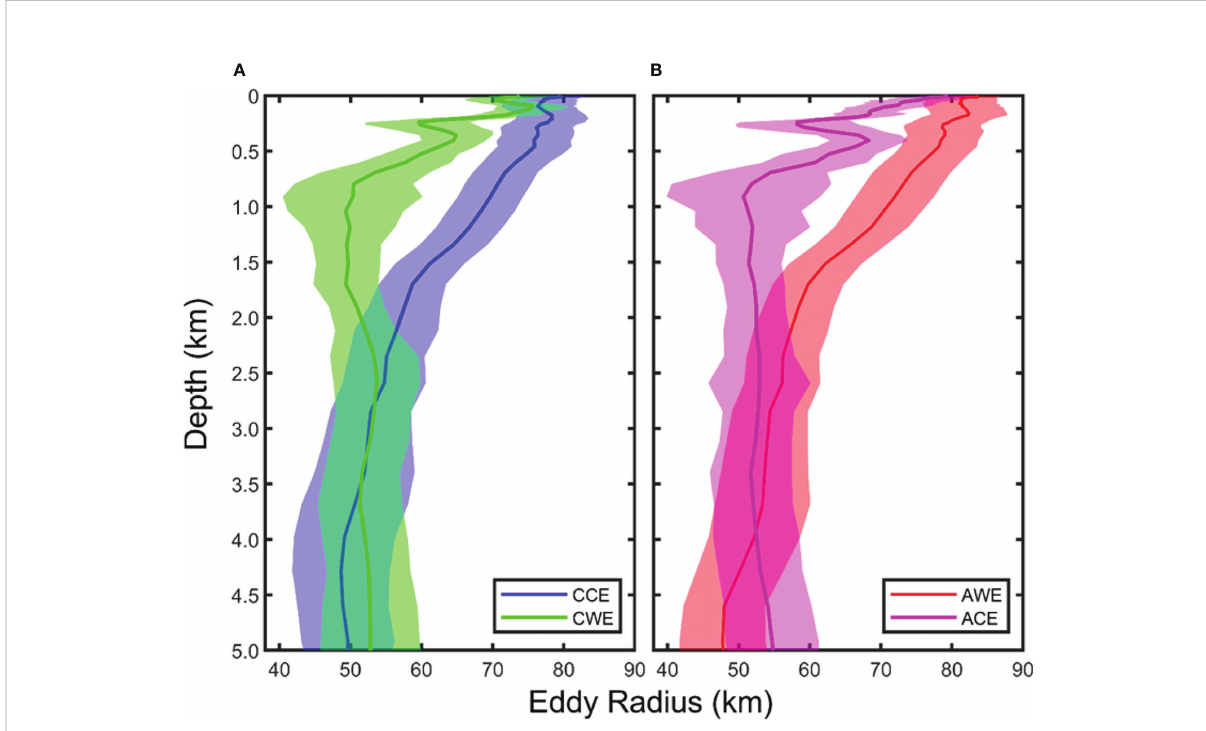
FIGURE 6 Vertical distribution of the average eddy radius from the four types of eddies in the STCC region. Blue, red, green, and magenta curves represent the average radius of cyclonic cold-core eddy (A) , anticyclonic warm-core eddy (B) , cyclonic warm-core eddy (A) , and anticyclonic cold-core eddy (B) , respectively (units: km). The shaded area represents the standard deviation of the corresponding eddy ’ s average